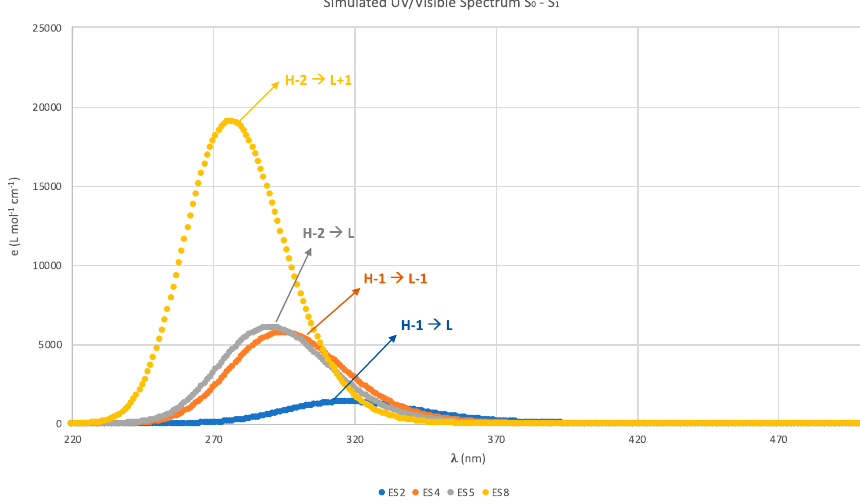
Figure 12. Calculated UV-vis optical absorption spectrum of fluorescein in water (PCM model).